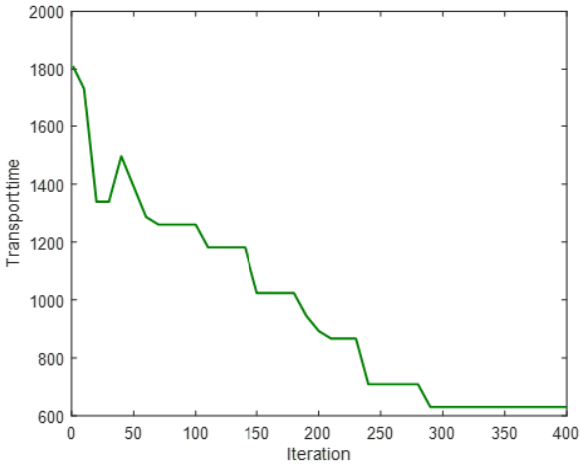
Figure 21. FAGA algorithm time target iteration curve.